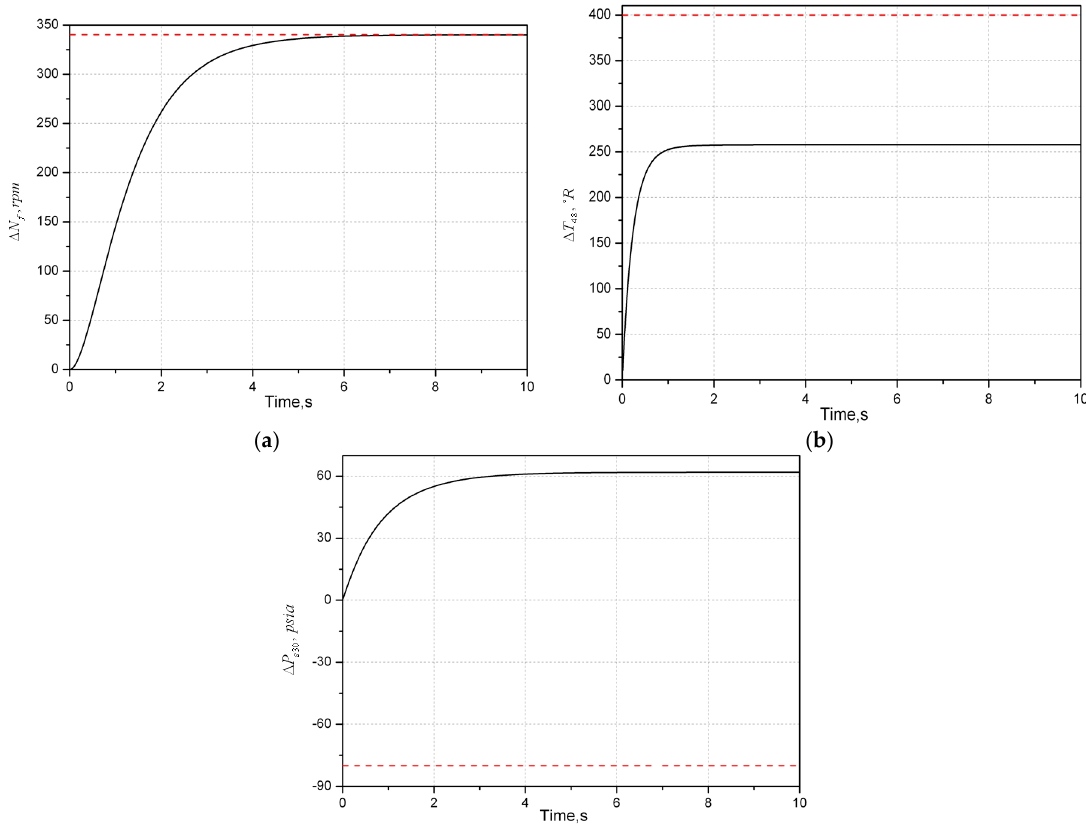
Figure 2. Output response with optimal augmented monotonic tracking controller (OAMTC) limit regulator: positive set-point change. ( a ) Fan speed response; ( b ) high-pressure turbine outlet temperature response; and ( c ) high-pressure compressor outlet static pressure response. Energies 2017 , 10 , 73